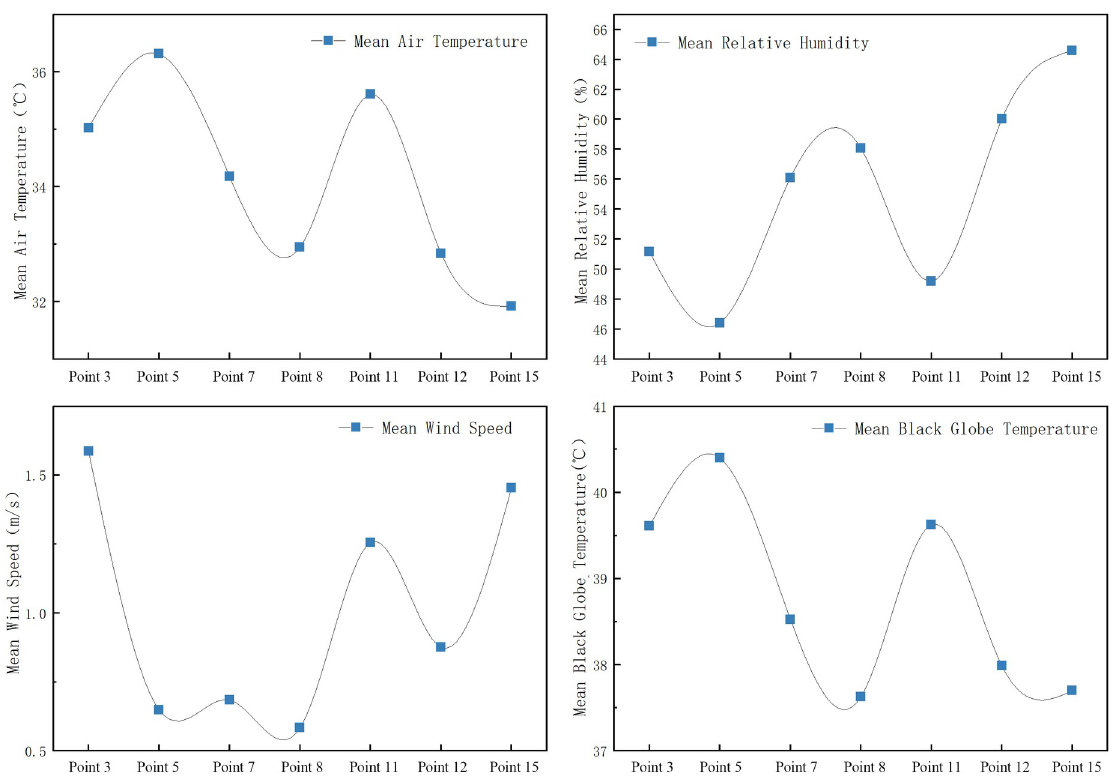
Fig 14. Mean variation of meteorological parameters at each measurement point in the